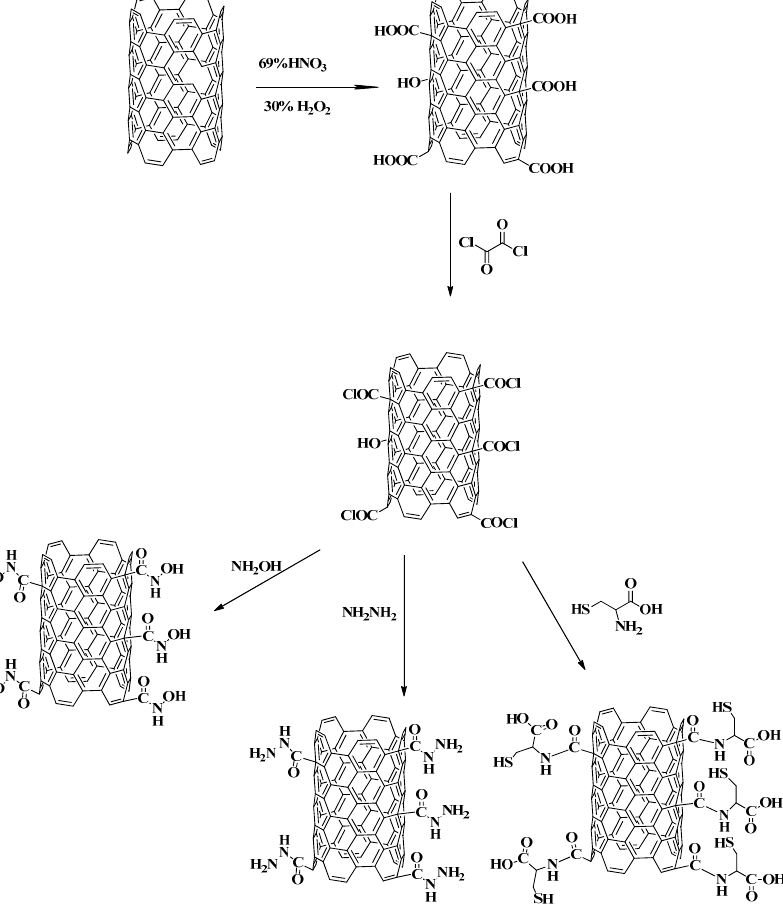
Figure 1. Preparation of magnetic functionalized multiwall carbon nanotube.